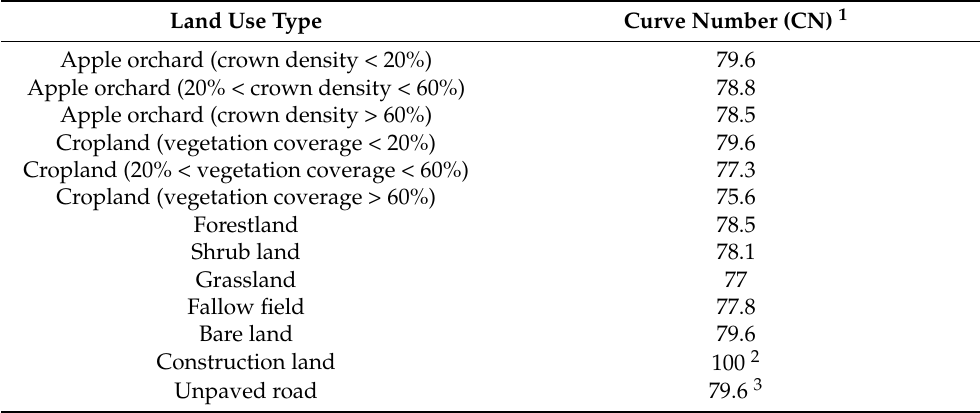
Table 2. CN values used to estimate runoff from the drainage area of each gully